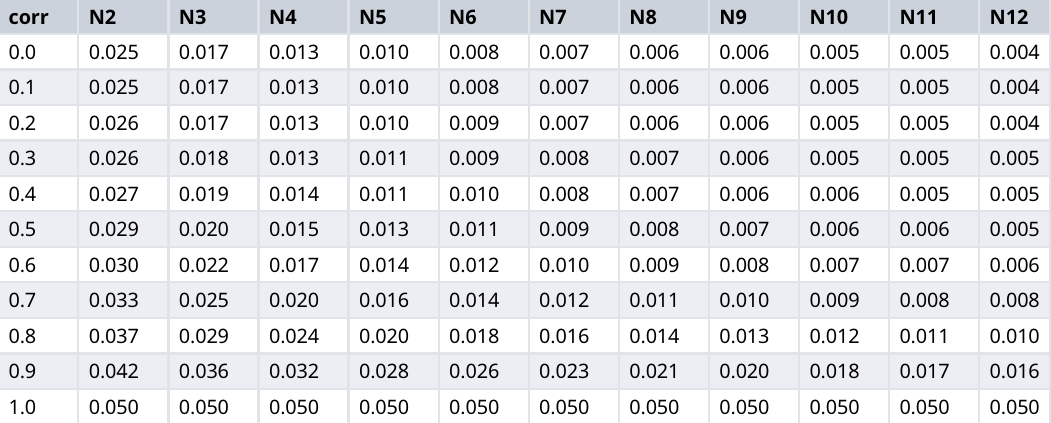
Table 2. AlphaMEff for different correlation values (corr) with 2-12 outcome variables (N2 to N12), based on Model